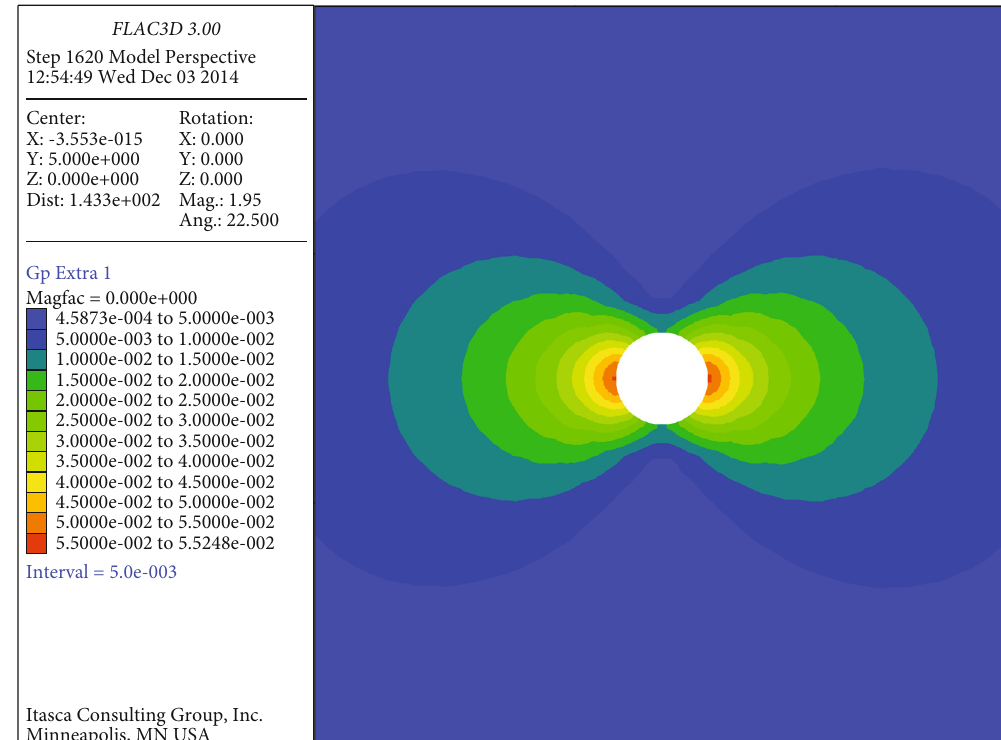
Figure 4: The radial displacement.